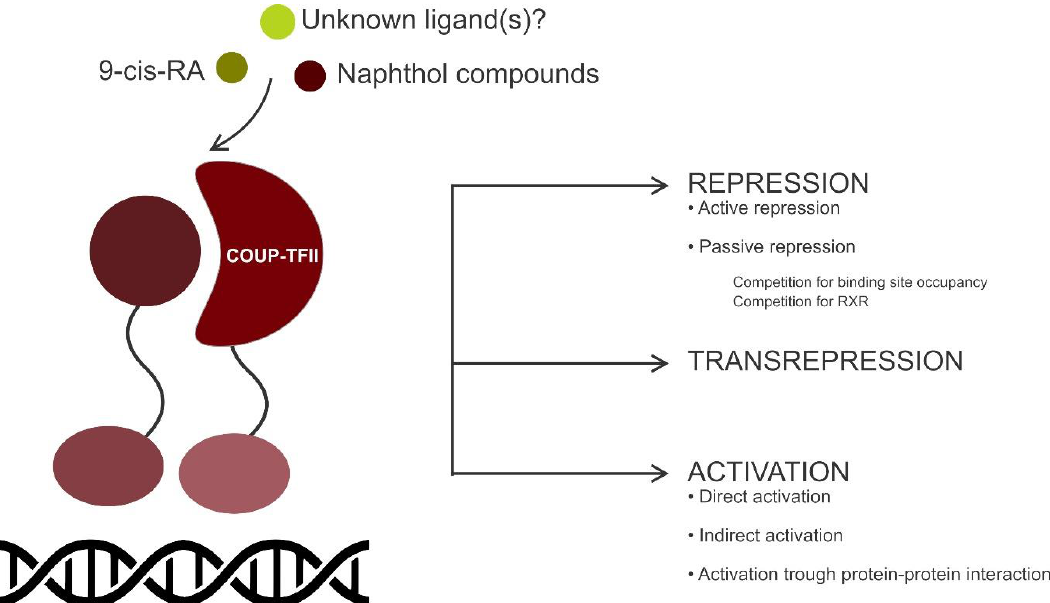
Figure 2. COUP-TFII dimerization and mechanism of action. COUP-TFII may form homo- and heterodimers and may act as a transcriptional repressor or activator, in a cell-dependent